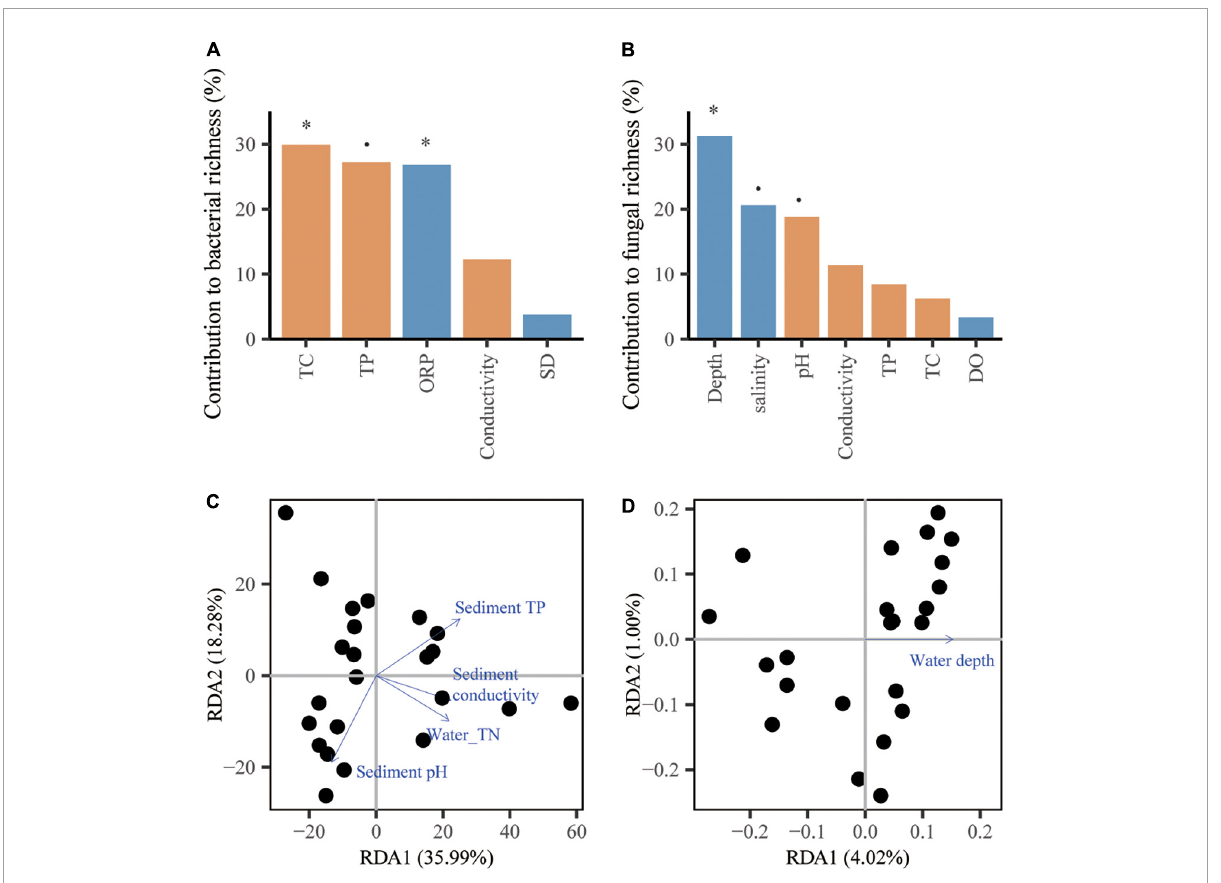
FIGURE3 The contributions of abiotic factors on microbial community attributes. The panels include random forest analyses of the richness of bacteria (A) and fungi (B) , and redundancy analysis (RDA) of the community compositions of bacteria (C) and fungi (D) represented by biplot graph. The columns filled with yellow and blue indicate sediment and water variable, respectively. The significance of each variable was shown above the column. p < 0.1, *p <